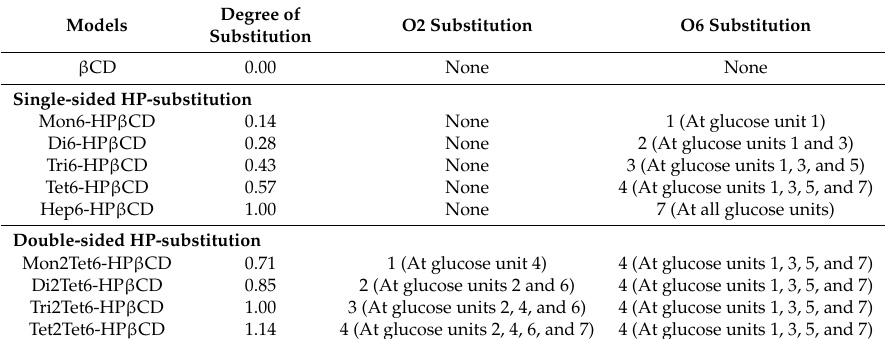
Table 1. Model summary of introducing HP groups at the O2 and/or O6 positions on glucose subunits.